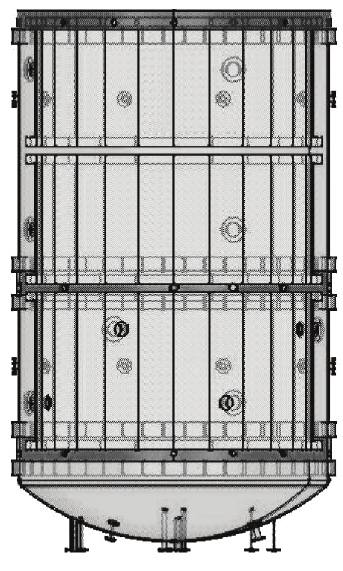
Figure 1: Schematics of MISTRA test facility